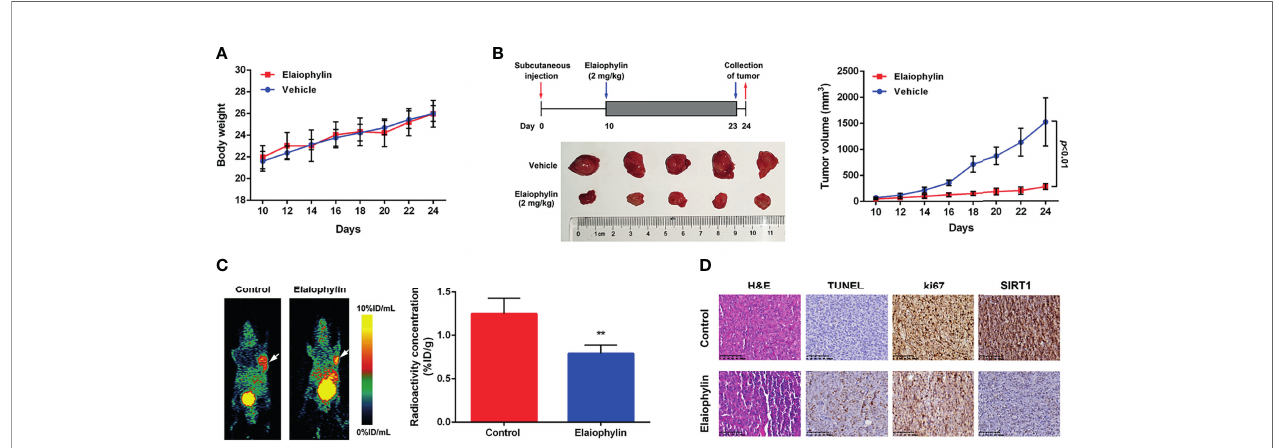
FIGURE 6 | Elaiophylin suppresses tumor growth in the C918-xenograft model by inhibiting SIRT1-mediated mitophagy. (A) Body weight of xenograft mice were measured every other day. (B) Tumor volumes were measured every other day. At the end of the treatment, the tumors were removed and photographed (n=5). The images of tumorswere shown on the leftand the tumor growth curve was displayedonthe right. (C) In vivo PET imaging ofC918-xenografted mice injected with [ 68 Ga]Ga- NOTA-PRGD 2 . Tumorsare indicated by arrows. ROIs are shownas mean %ID/g ± SD. (D) H&Estainingof tumor sectionsof C918-xenograftmice. TUNEL and immunohistochemistry staining of ki67 and SIRT1 were performed. The representative images of staining are shownhere. Data was expressedas mean ± SDofthree experiments. ** p <0.01 vs.